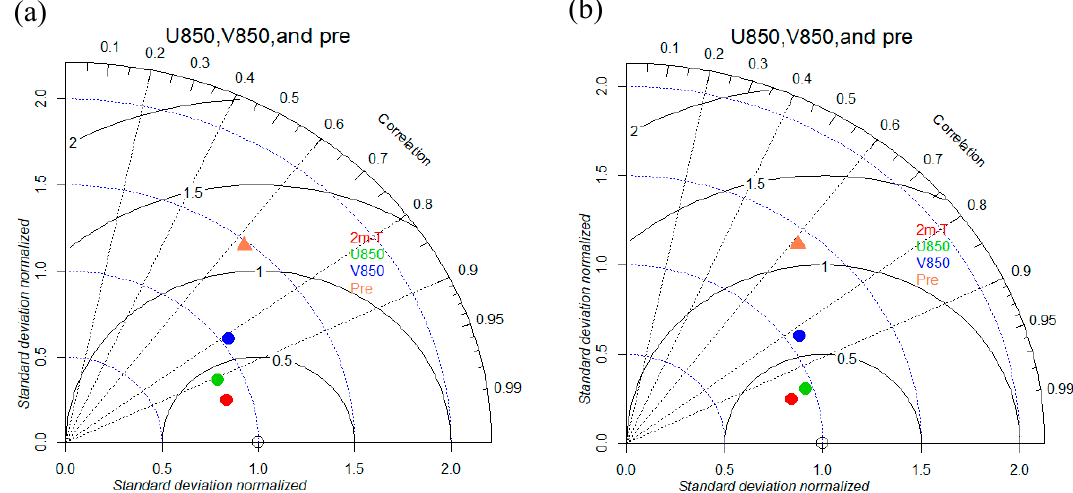
Figure 2. Taylor assessment chart (model results and observations). ( a ) CTL_N; ( b ) CTL_P. The red dots represent the 2-m air temperature, green dots represent zonal wind in 850 hPa, blue dots represent meridional wind in 850 hPa, and orange dots represent precipitation. The domain for East Asia is 20–60 °N, 110–140 °E.